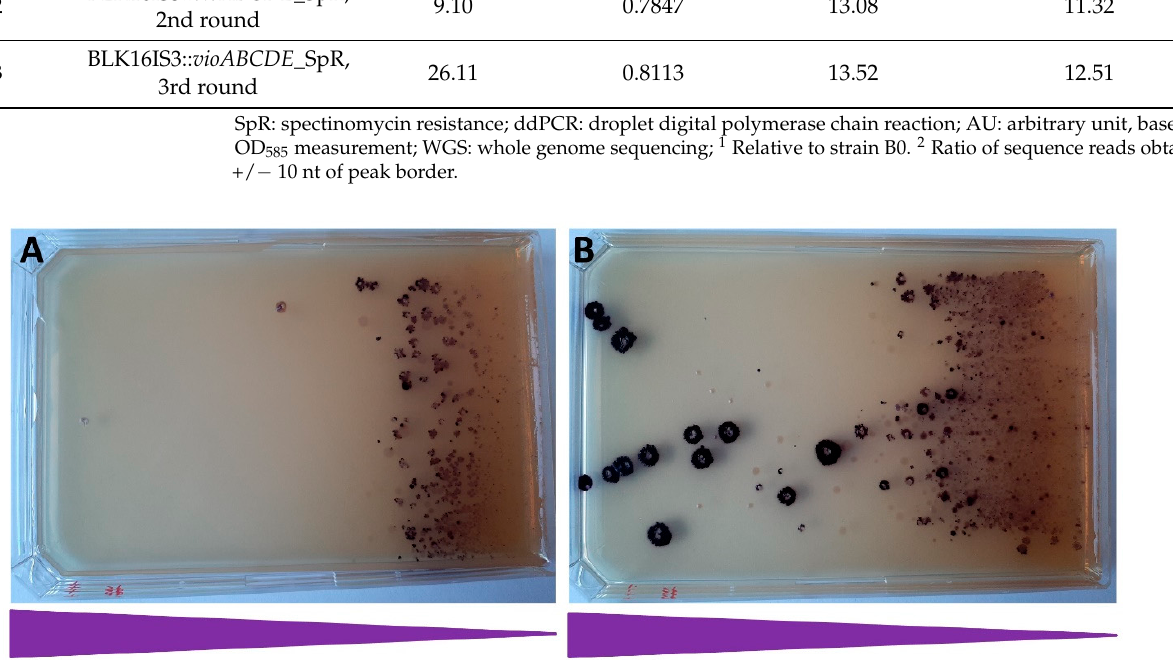
Figure 7. The effect of one round of IS 3 transposase induction on the Sp-resistance of BLK09IS 3 :: vioABCDE _SpR (locus 2) colonies. Note the intense purple colors of the colonies caused by violacein. ( A ) Uninduced cells; and ( B ) cells treated with aTc to induce transposase expression. The triangles represent the gradient of Sp concentration within the